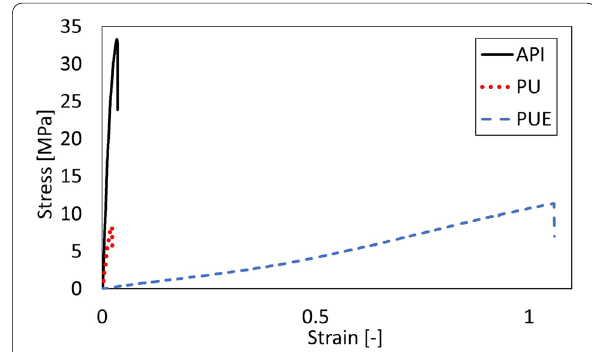
Fig. 2 Stress–strain curves for three types of adhesive films in uni-axial tensile tests